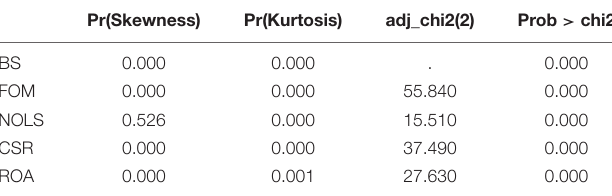
TABLE 10 | Skewness and kurtosis test.